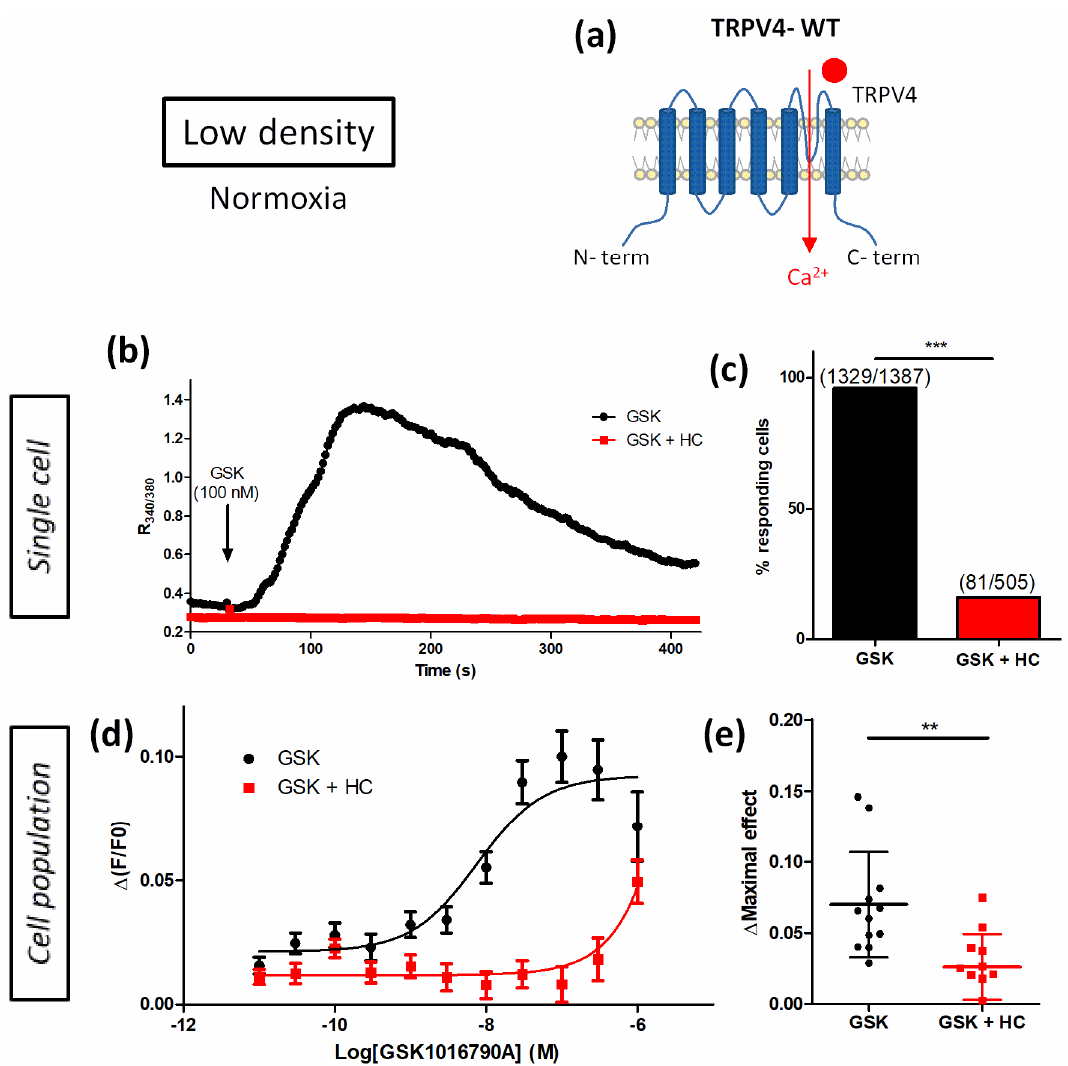
Figure 2. Characterization of TRPV4 Ca 2+ response in transiently TRPV4-transfected HEK293T (HEK-TRPV4) cells cultured under normoxia at low density (1 × 10 4 cells/cm 2 ). ( a ) Schematic representation of TRPV4-WT. ( b , c ) Variations of relative cytosolic Ca 2+ concentration (Ratio R 340/380 ) were monitored by single-cell fluorescence videomicroscopy in Fura-2-LR/AM loaded cells. HEK- TRPV4 were bathed in physiological saline solution in absence or presence of the specific TRPV4 inhibitor HC067047 (HC, 1 µM). ( b ) Typical recordings of single cells when GSK1016790A (GSK, 100 nM), a selective TRPV4 agonist, was added at 30 s (as indicated by the arrow), and ( c ) percentage of responding cells in response to GSK. ( d , e ) Variations in relative cytosolic Ca 2+ concentration (F/F0) were monitored using a microplate spectrophotometer reader in Fluo-4/AM loaded cells. ( d ) Δ(F/F0) concentration–response curves to GSK1016790A in presence or absence of HC067047 (1 µM) and ( e ) maximal concentration–response curve amplitude (ΔMaximal effect). Data are expressed as mean value ± SD. The number of cells ( c ) is indicated in brackets. Significant difference is indicated by two asterisks when p < 0.01 and three asterisks when p < 0.001, Mann–Whitney or chi-squared test. 3.1.2. Hypoxia Potentiates TRPV4-Induced Ca 2+ Responses in Low-Density Cultured Cells Previous studies have shown that prolonged hypoxia exposure occurring particularly, but not exclusively, in a variety of chronic lung diseases, increases TRPV4 activity in pulmonary arterial smooth muscle cells (PASMC) [13,14]. Moreover, a similar